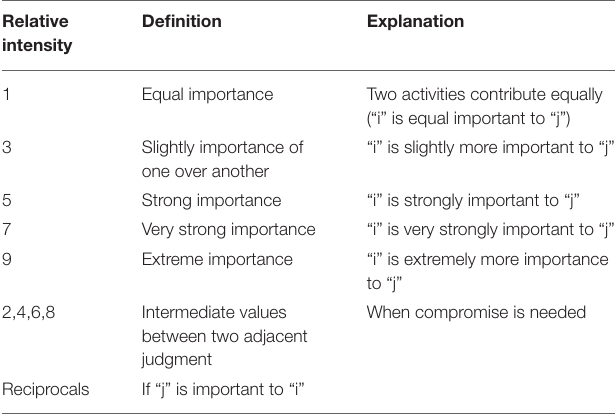
TABLE 3 | Average Random Consistency ( Al-harbi, 2001; Dweiri and Al-oqla,